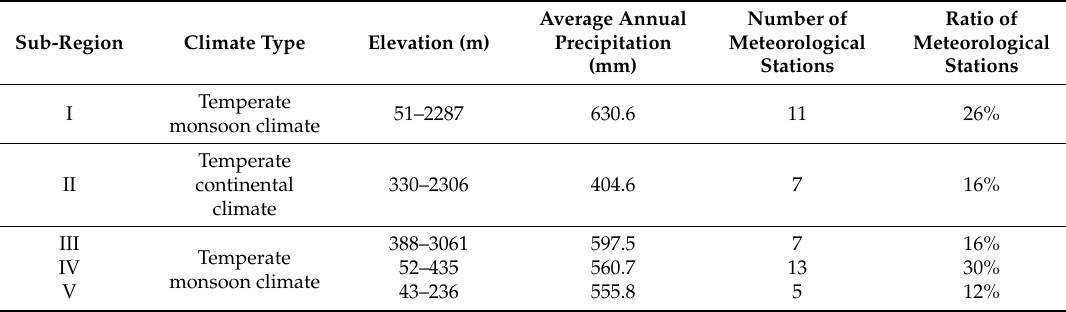
Table 1. Basic information of each sub-region of the Haihe River